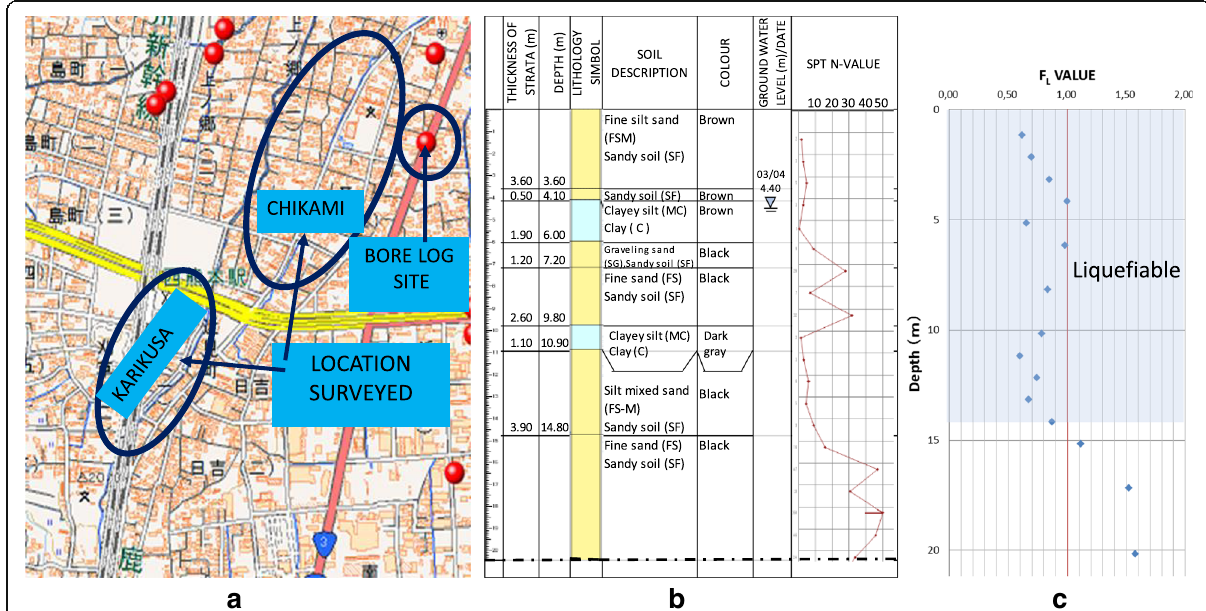
Fig. 14 a Bore log site in Chikami and Karikusa; b Borehole data obtained; c FL values calculation result for Chikami and Karikusa